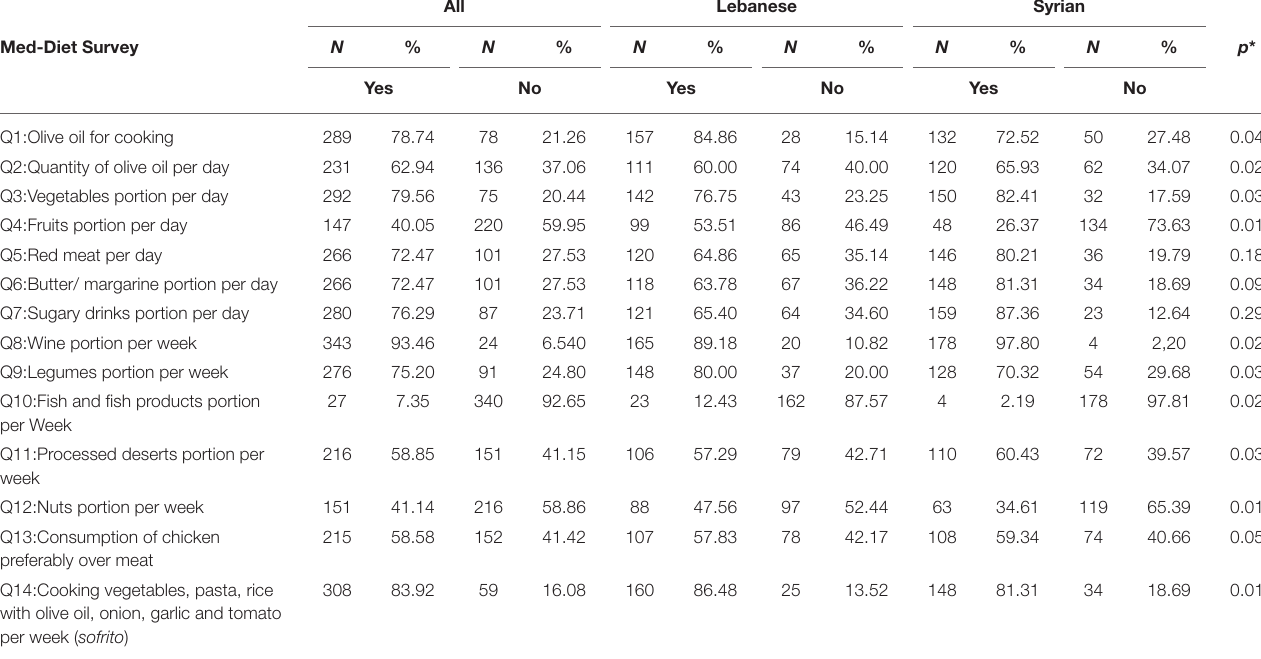
TABLE 3 | Stratification of adherence to MedDiet